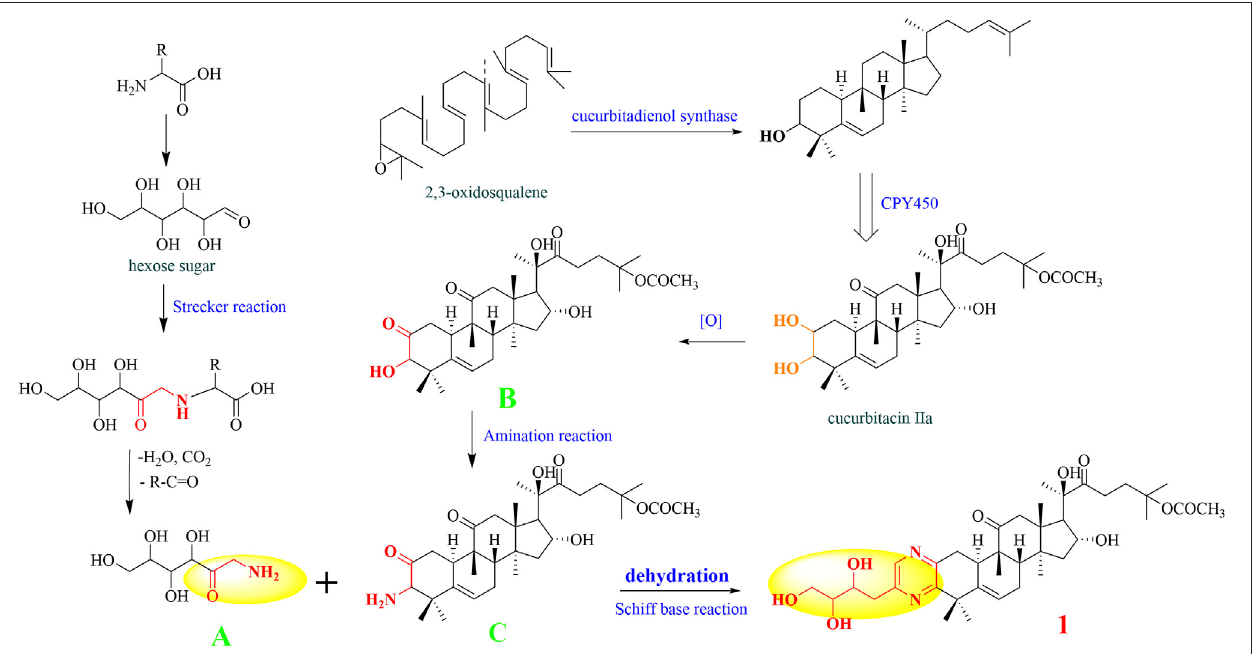
FIGURE 7 | Putative biosynthetic pathway of compound 1 .